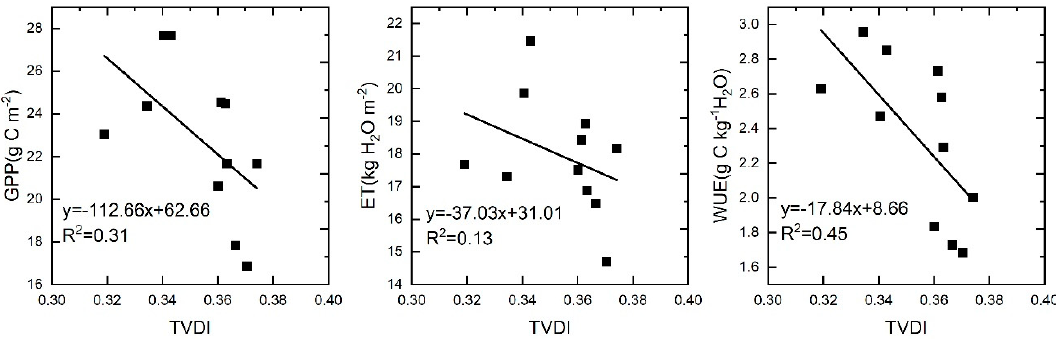
Figure 10. Regression analysis of drought intensity and gross primary productivity (GPP), evapotranspiration (ET), and